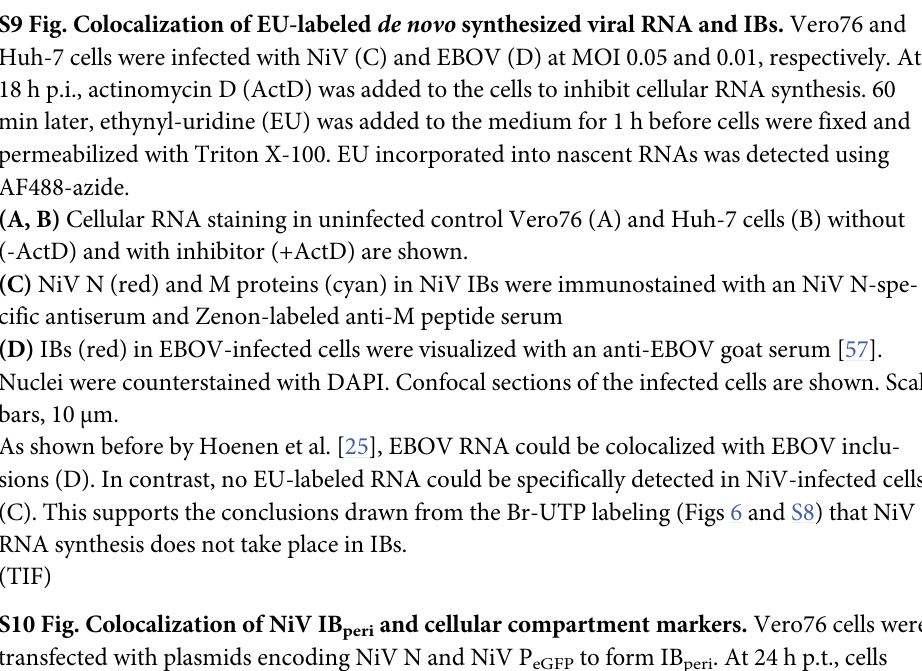
and cellular compartment markers. Vero76 cells were peri to form IB . At 24 h p.t., cells eGFP peri ), enlarged views of the merged peri